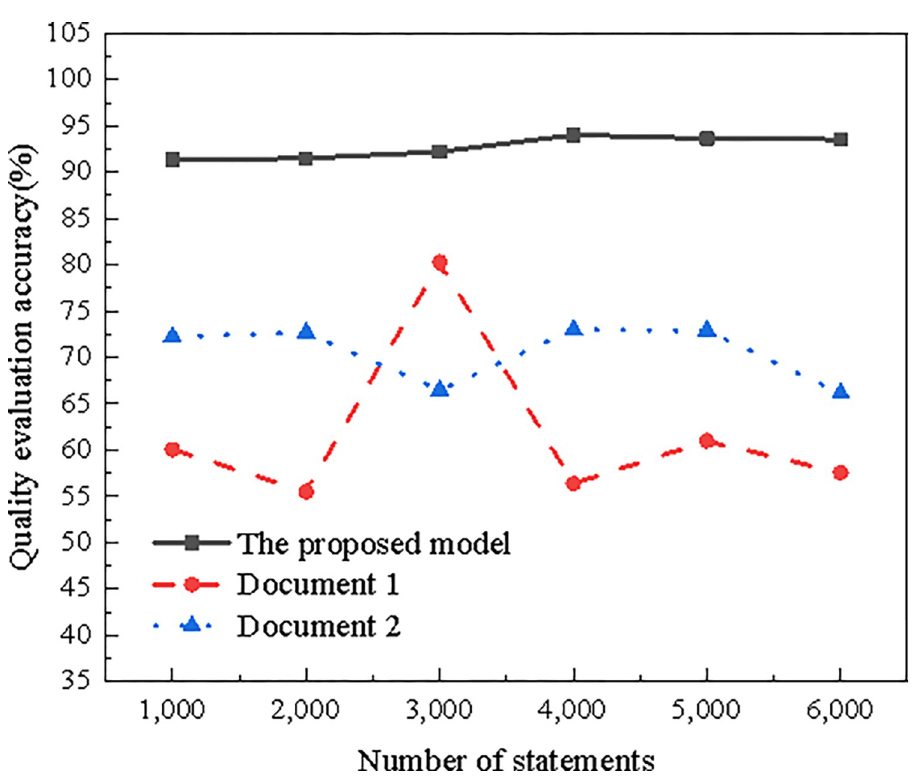
Fig 12. Comparison of model quality evaluation efficiency under different number of